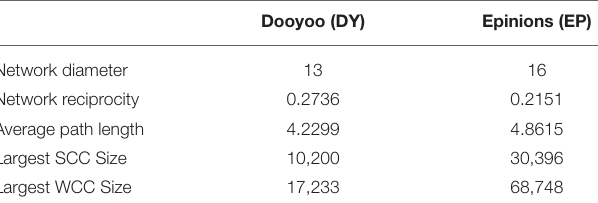
TABLE 3 | Network statistics of the analyzed datasets, Dooyoo and Epinions .